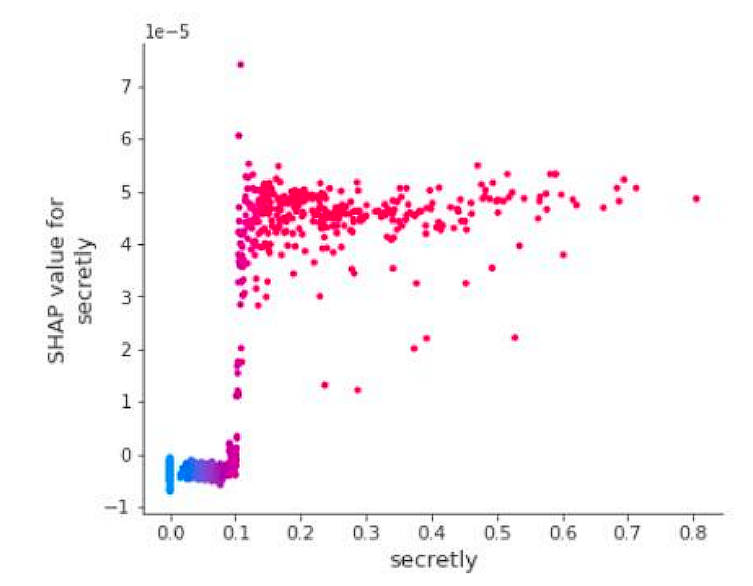
Figure 7. An example of interpretable machine learning result in the context of the Game Analytics Scenario scenario: dependency plot for classification of games, Cardgames category, “secretly” feature. Horizontal axis shows TF-IDF values, vertical axis SHAP